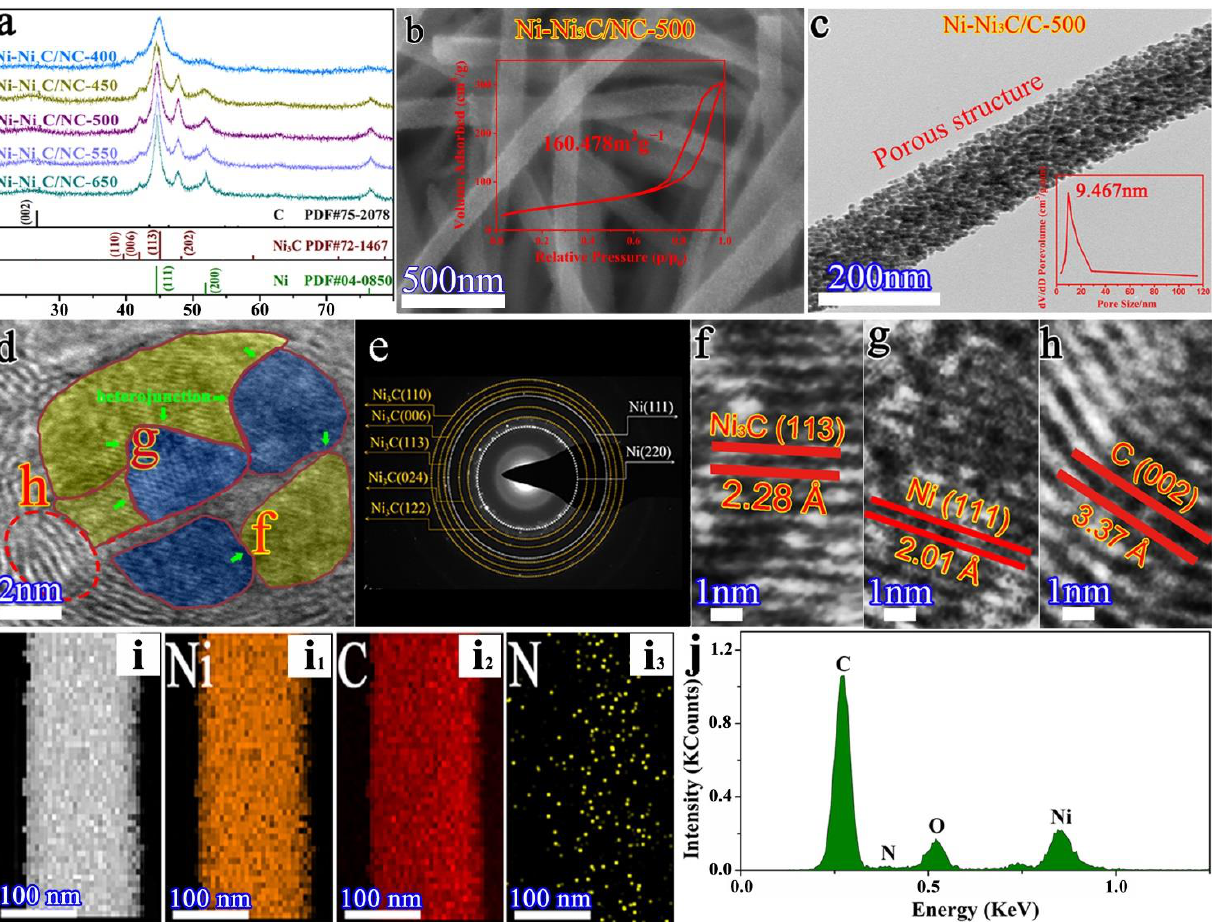
Figure 1. Microstructure and composition characterizations of the samples prepared under different thermal decomposition temperatures (400–650 °C). The Ni-Ni 3 C/NC-500 sample had the best activity in the following electrocatalytic measurements. ( a ) XRD patterns of various as-prepared Ni-Ni 3 C/NC samples. ( b , c ) SEM and TEM images of Ni-Ni 3 C/NC-500. Insets are its N 2 adsorption-desorption isotherm and pore-size distribution curve, respectively. ( d – h ) HRTEM and SAED images of Ni-Ni 3 C/NC-500. ( d ) shows Ni-Ni 3 C/NC-500 composition distribution (yellow section: Ni 3 C, blue section: metal Ni) and heterojunction interface. ( e ) shows the heterostructure’s lattice fringes. ( f – h ) show Ni 3 C, Ni, and C lattices. ( i , j ) EDX elemental mappings and EDS spectrum of Ni-Ni 3 C/NC-500. Scale bars are 100 nm.